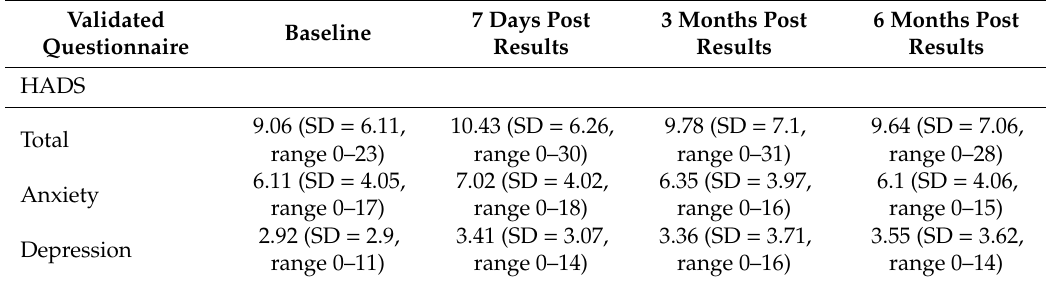
Table 4. Mean questionnaire scores at baseline and at seven days, three months and six months follow